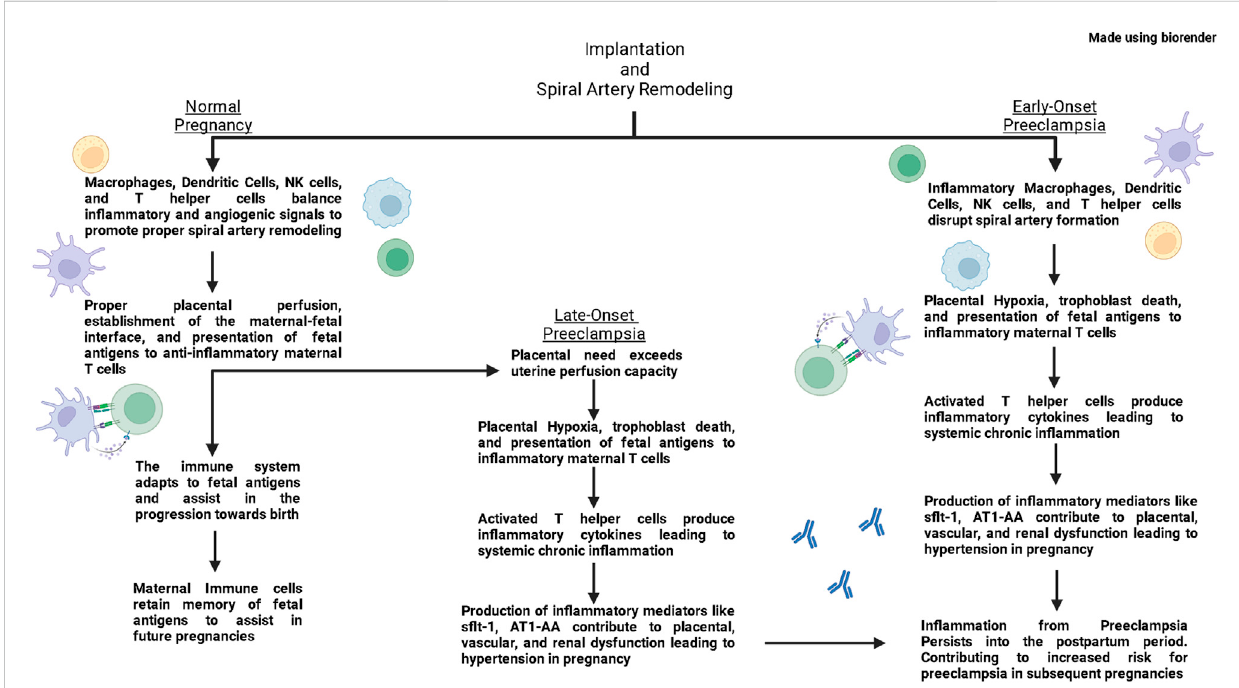
FIGURE 1 In normal pregnancies, macrophages, dendritic cells, Natural Killer (NK) cells, and T helper (Th) cells produce both in fl ammatory and anti- in fl ammatory signals that support vascular remodeling and promote spiral artery remodeling. As pregnancy progresses, antigen presenting cells present fetalantigenstoThcellsandpolarizethemtowardsaregulatoryThcellphenotype(Tregs).TheseTregsthenquellimmuneresponsesintheplacentaand maintain an anti-in fl ammatory environment through the second trimester. As a normal pregnancy reaches its end, maternal immune cells produce in fl ammatory signals that help signal the uterus for delivery. In the postpartum period, maternal immune cells retain memory of fetal antigens to help in future pregnancies. In early-onset preeclampsia, in fl ammatory macrophages, dendritic cells, NK cells, and Th cells disrupt spiral artery formation leading toplacentalhypoxia.Hypoxialeadstocelldeathwhichleadstoplacentaldysfunctionandreleaseoffetalantigens.AntigenPresentingCellspresentthese fetal antigens and polarize Th cells toward an in fl ammatory phenotype. In fl ammatory Th cells then induce production of in fl ammatory and anti- angiogenic factors from the placenta and other immune cells which lead to placental, vascular, and renal dysfunction contributing to hypertension in pregnancy. These in fl ammatory cells from preeclampsia retain memory postpartum, and increase the risk for developing PE in subsequent pregnancies. Inlate-onsetpreeclampsia,thespiralarteryformationoccursnormally,howevereventuallytheneedsoftheplacentaout-weightheperfusioncapacityof the uterus, leading to placental hypoxia and a similar in fl ammatory environment as seen in early-onset